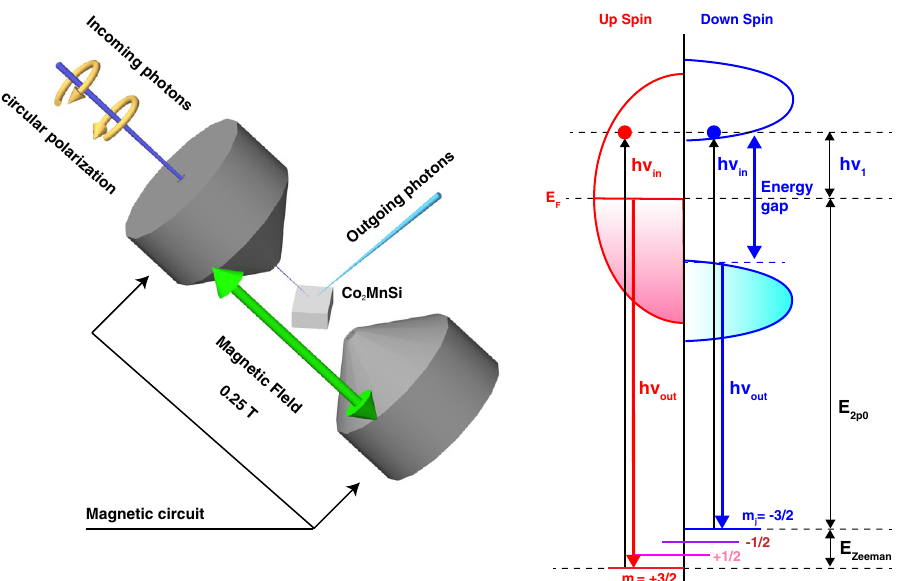
Figure 1. ( a ) Geometry of the RIXS experiments under the magnetic field. The illustration was drawn with Vectorworks 2019 software. ( b ) The optical process of RIXS-MCD. The relative photon energy is defined as h ν 1 = h ν in − E 2 p E 2 p E F and 2 p 3 / 2 m j = − 3 / 2 0 , where 0 is the energy difference between the